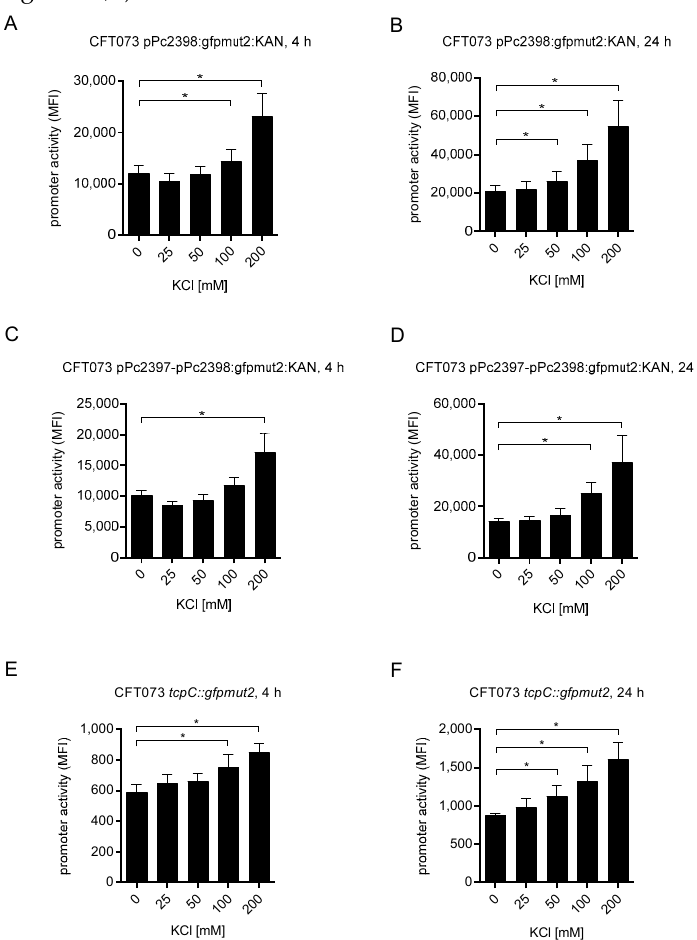
Figure 5. CFT073 senses potassium chloride. We cultured CFT073 pPc2398:gfpmut2:KAN (over- night culture diluted 1:6) in M9-minimal medium in the absence or presence of increasing amounts of potassium chloride for 4 ( A ) or 24 h ( B ) and determined the P2 promoter activity by flow cytom- etry. We repeated the experiment with CFT073 pPc2397-Pc2398:gfpmut2:KAN (overnight culture